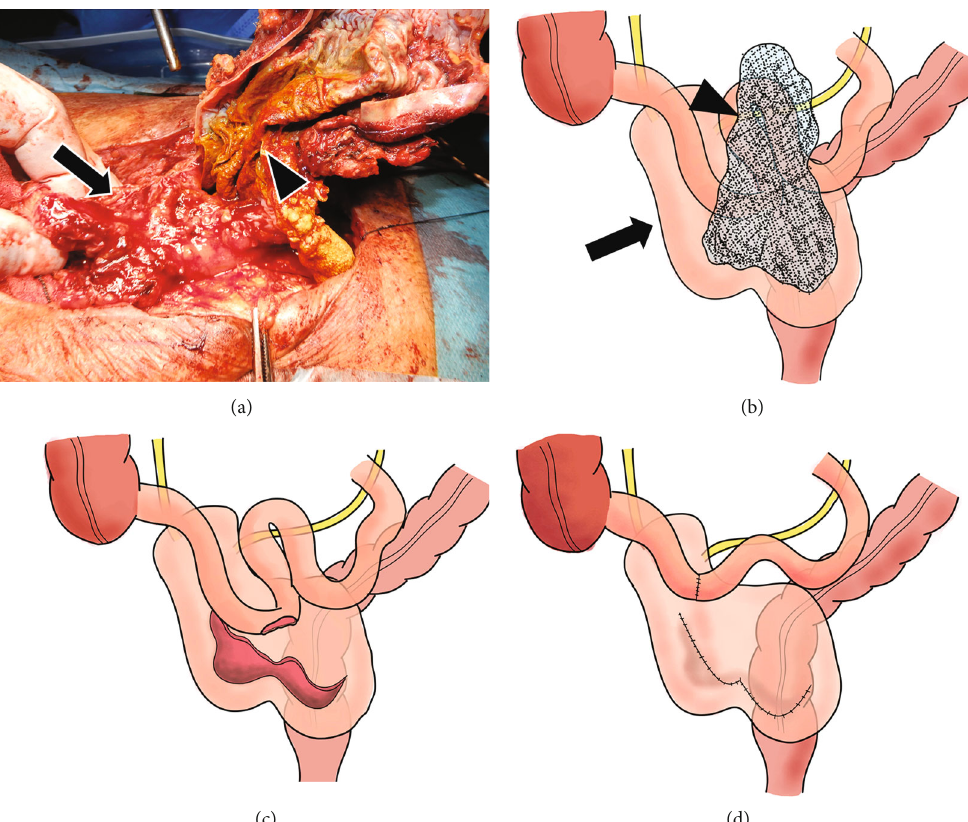
Figure 3: Intraoperative fi ndings. The mesh (arrowhead) migrated into the neobladder (arrow) and the small bowel (a, b). Partial resection of the small intestine and partial neobladder resection were performed (c). The neobladder wall was closed in a straightforward manner